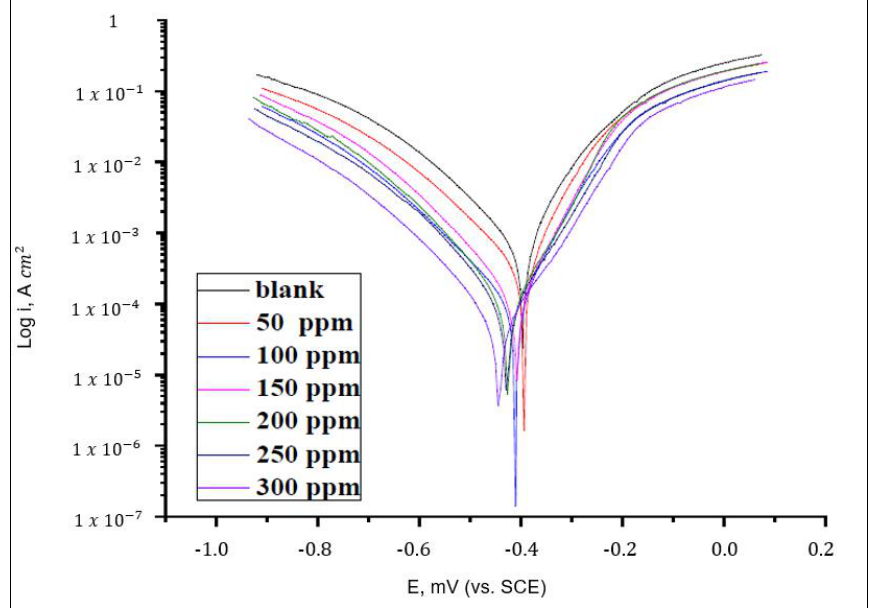
Figure 15. Potentiodynamic polarization plots for various concentrations of Clinopodium acinos with mild steel in 1 M HCl. Reprinted from [51].